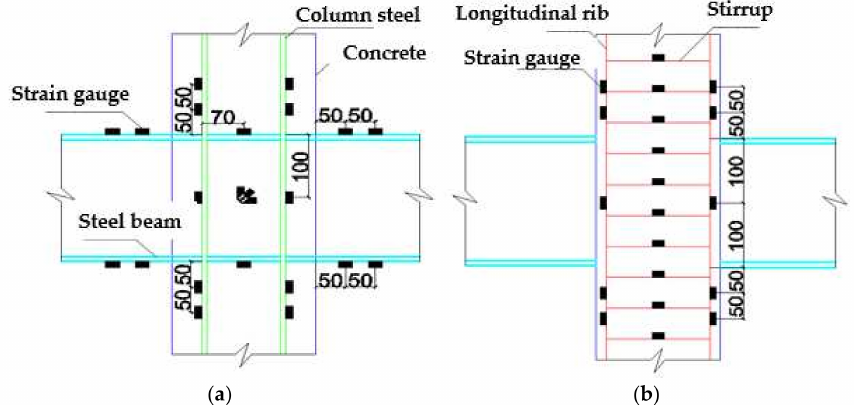
Figure 5. Positions of strain gauges. ( a ) Strain gauges on steel frame; ( b ) Strain gauges on steel